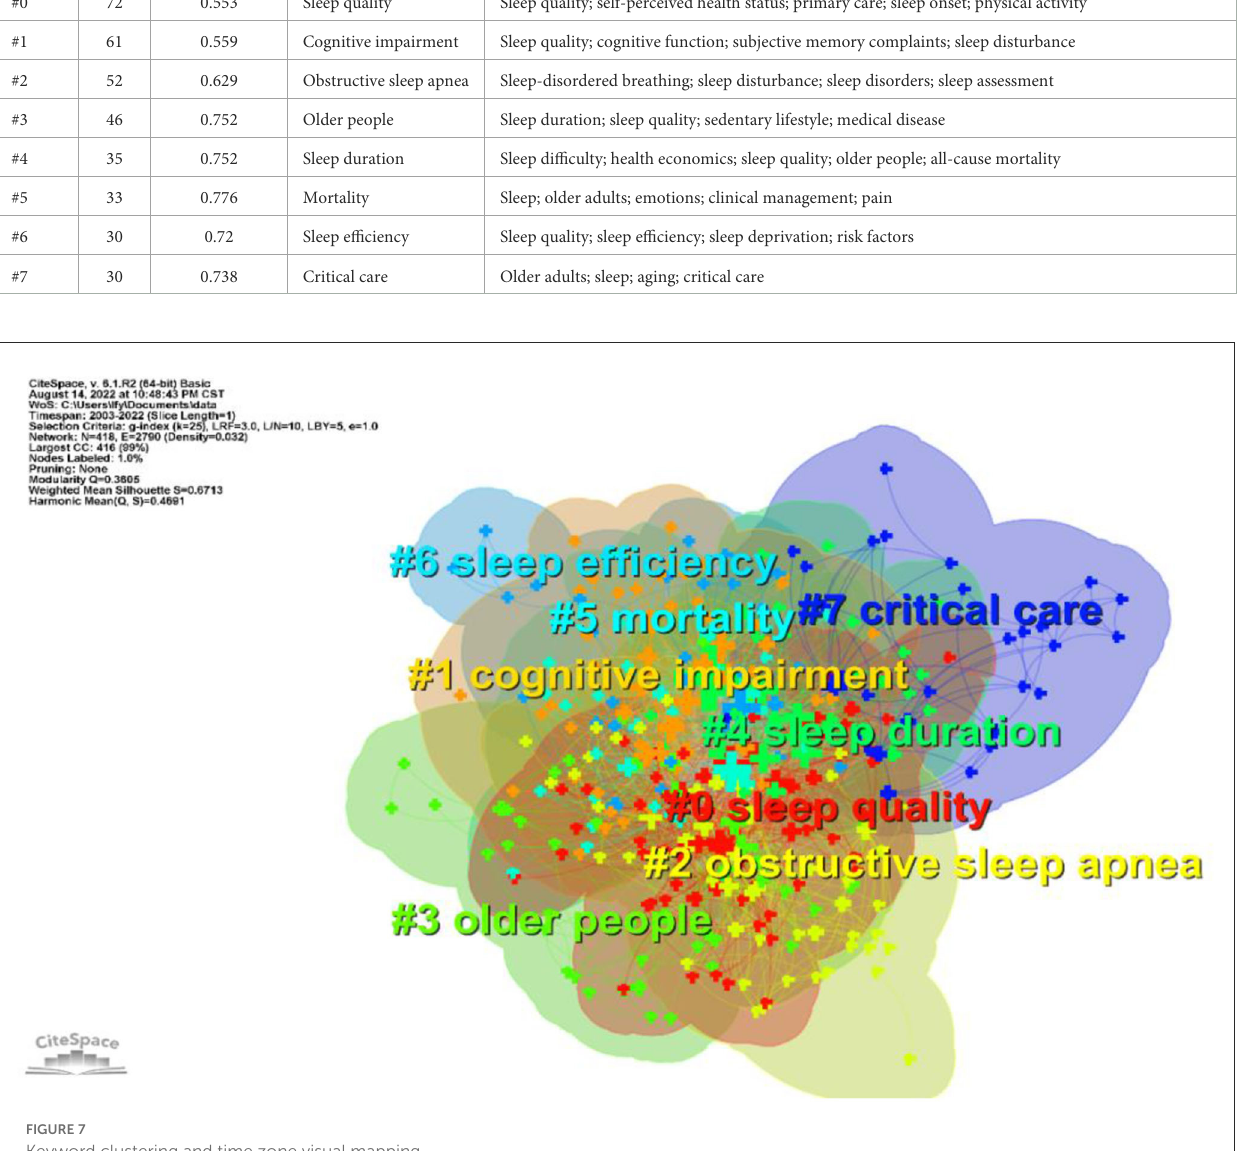
FIGURE7 Keyword clustering and time zone visual mapping.